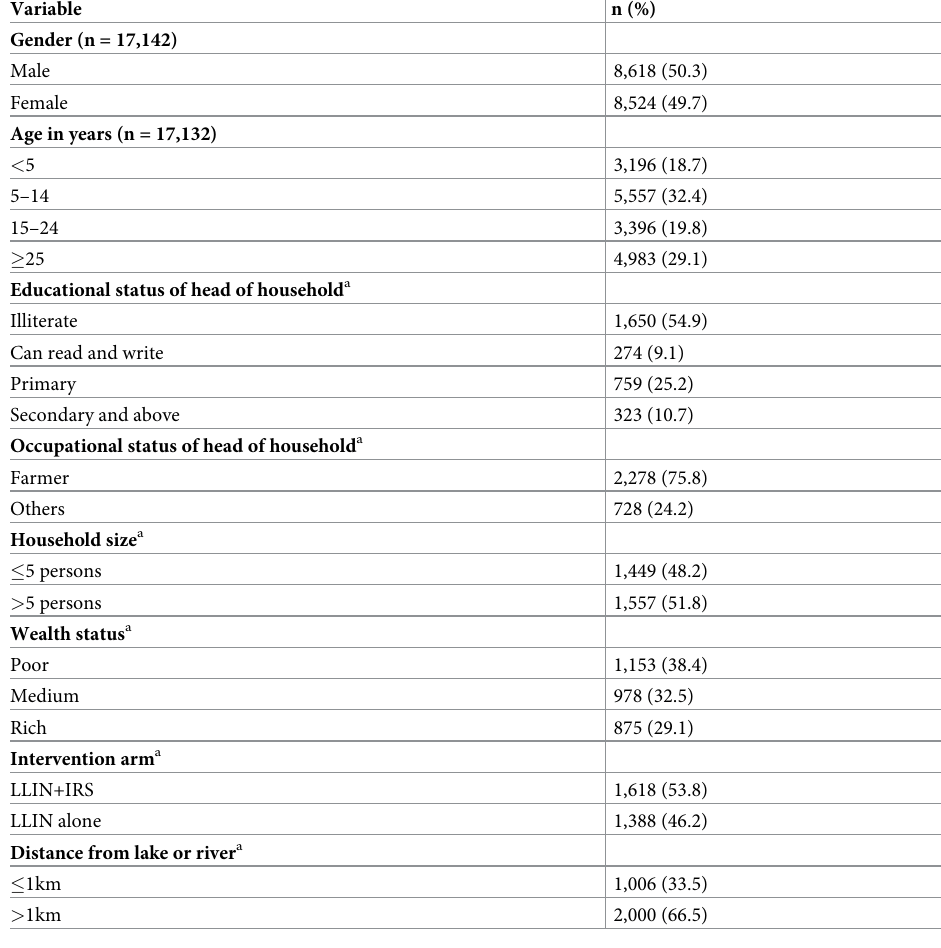
Table 1. Characteristics of the study participants and their households,